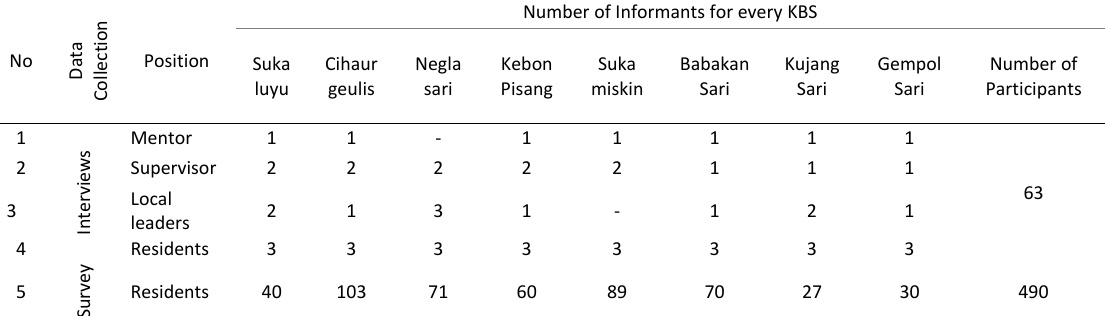
Table 1: Key Informants of the study